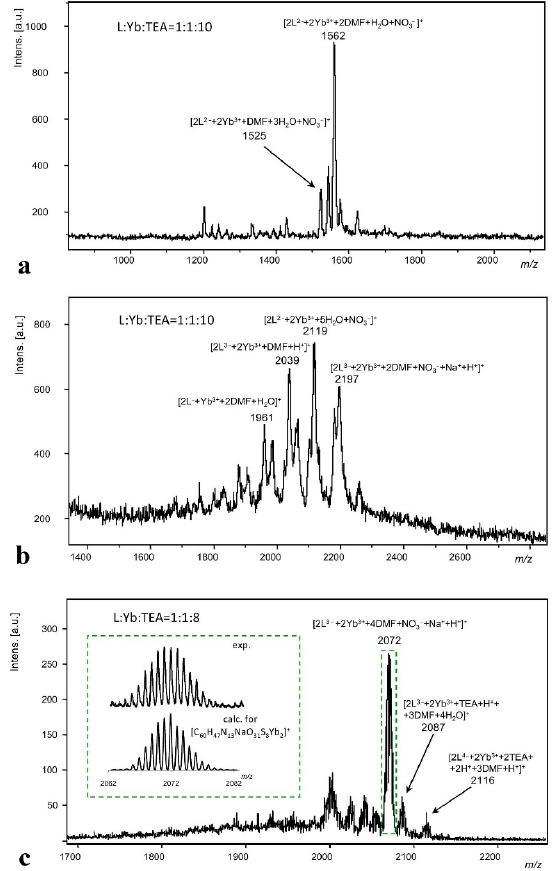
Figure 7. MALDI-TOF mass spectra of the H 4 L-Yb 3+ -TEA (1:1:8, 1:1:10) system: L = ( a ) H 4 L( 1 ); ( b ) H 4 L( 2 ); ( c ) H 4 L( 3